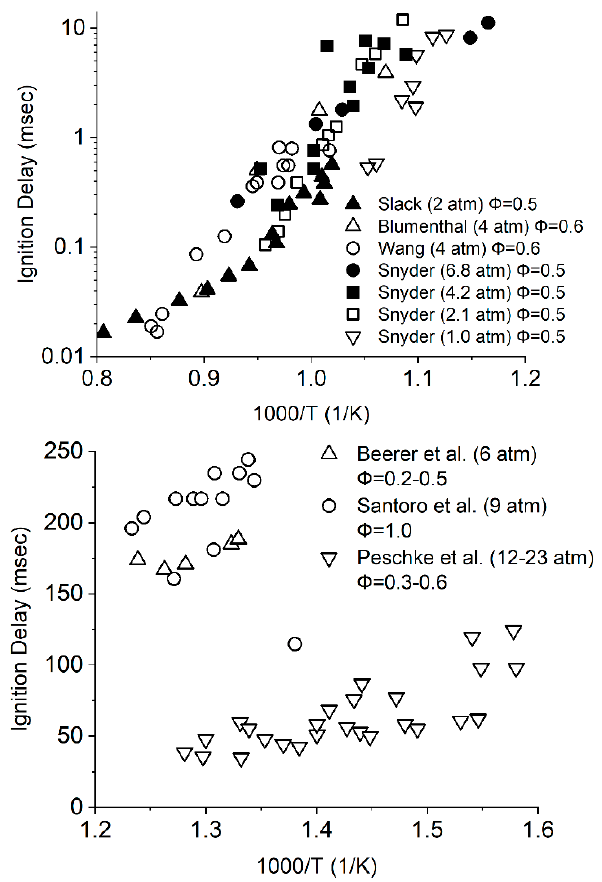
Figure 6. Change in the ignition delay time of a natural gas mixture depending on the volume fraction of hydrogen [14,15].